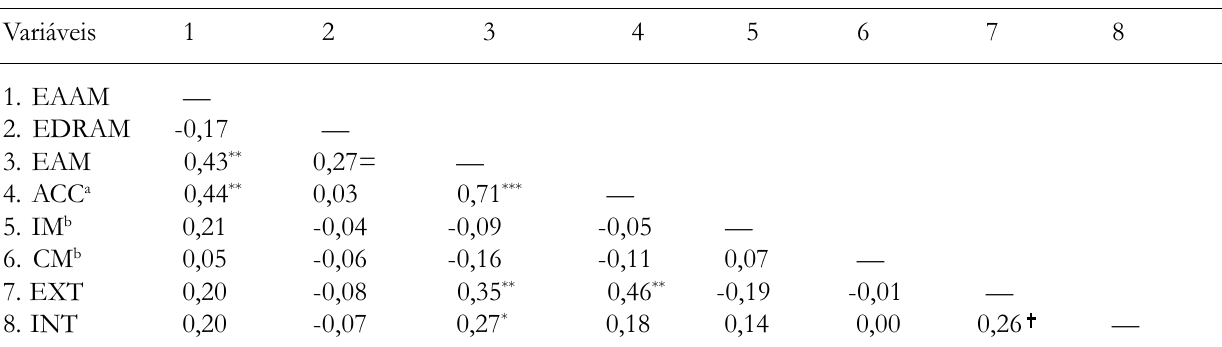
Tabela 2. Matriz das Correla(cid:231)ıes de Pearson de Ordem Zero ( n